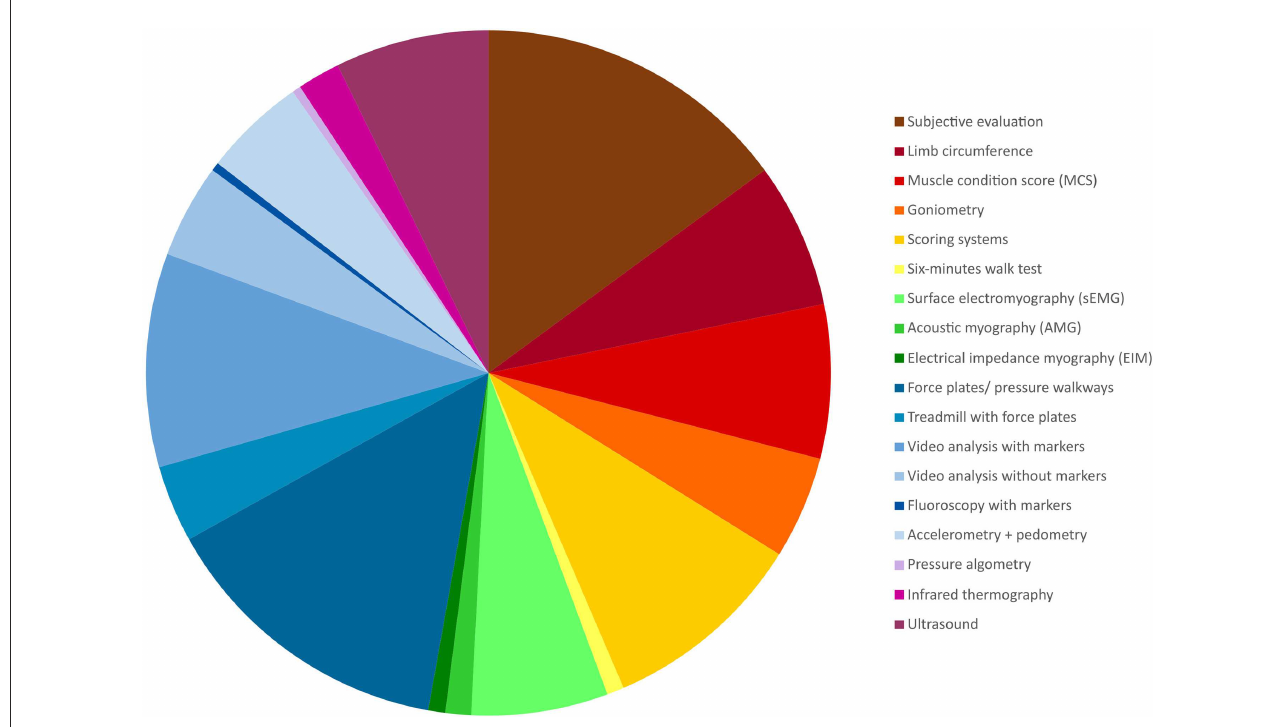
FIGURE2 Pie chart visualising the distribution of the identified method categories based on all observations ( n = 248).